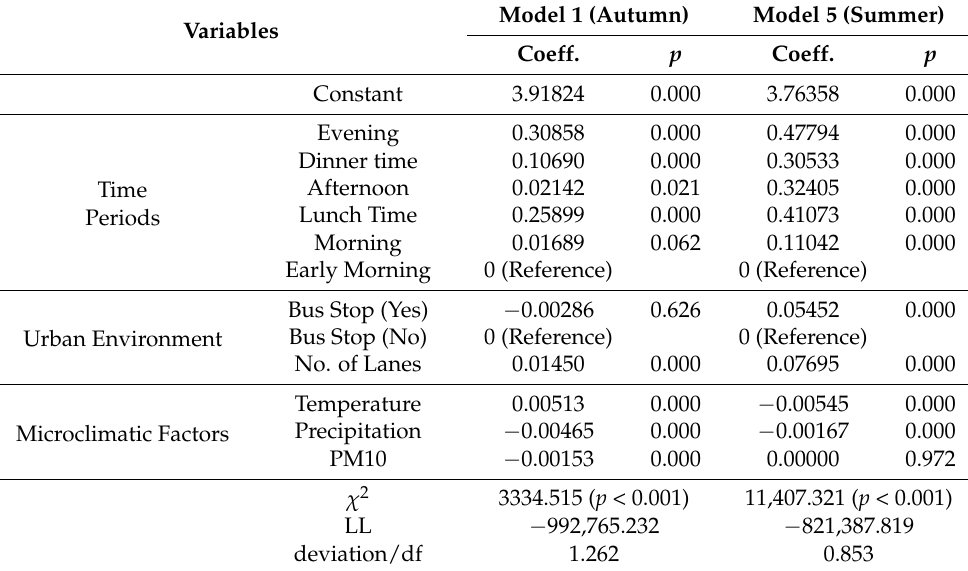
Table 8. Negative binominal regression analysis results by